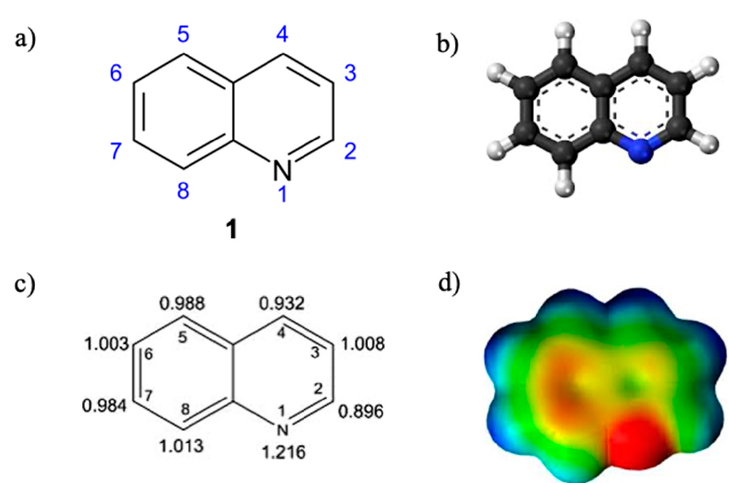
Figure 1. ( a ) Quinoline 1 or 1-aza-naphthalene and benzo[ b ]pyridine; ( b ) quinoline 3D structure; ( c ) quinoline electron density; ( d ) electron density encoded with the electrostatic potential.